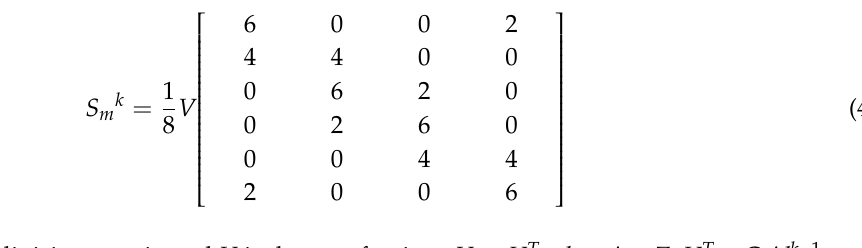
Figure 3. The regular hexagonal element with ( a ) symmetrical lines and. ( b ) geometric parameters including interior angles ( c ), and ( d ) outputs. Considering the second case, the 𝑆 (cid:3031) parameter is varied for 𝑆 (cid:2869) and 𝑆 (cid:2870) . Irregular pattern elements with ℎ ≠ 𝑙 sides are generated. When the element sides satisfy the following condition, ℎ >